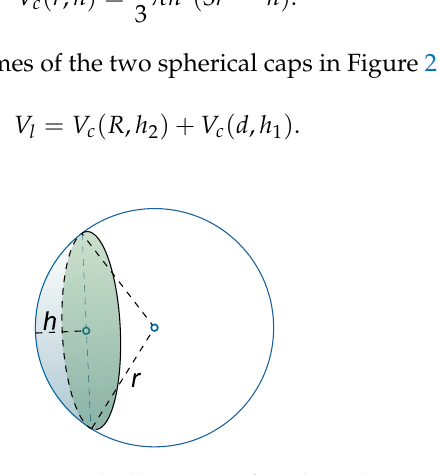
Figure 3. An example illustration of a spherical